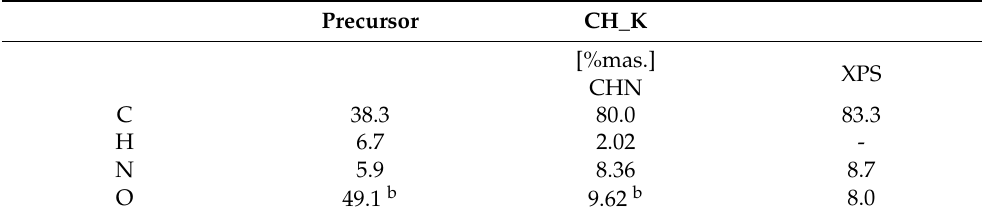
Table 2. Elemental analysis using the CHN combustion method and XPS